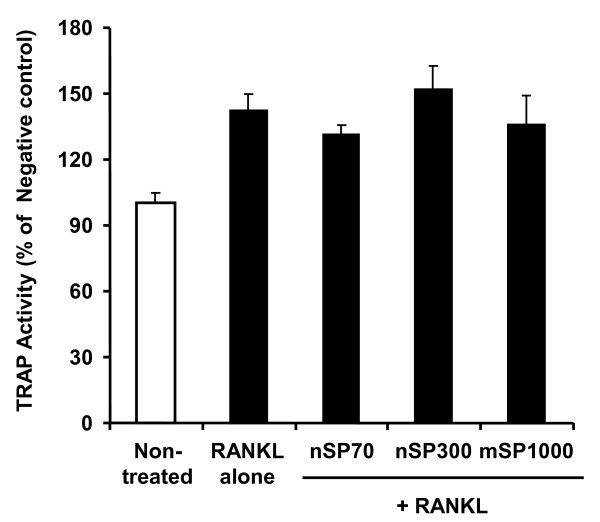
Effect of silica particles on the RANKL-induced TRAP activity in RAW264.7 cells. RAW264.7 cells were incubated with 10 μg/ml silica particles and 30 ng/ml RANKL for 5 days. TRAP activity was calculated relative to the negative controls (medium without RANKL). Data are expressed as the mean ± SD (n = 3).